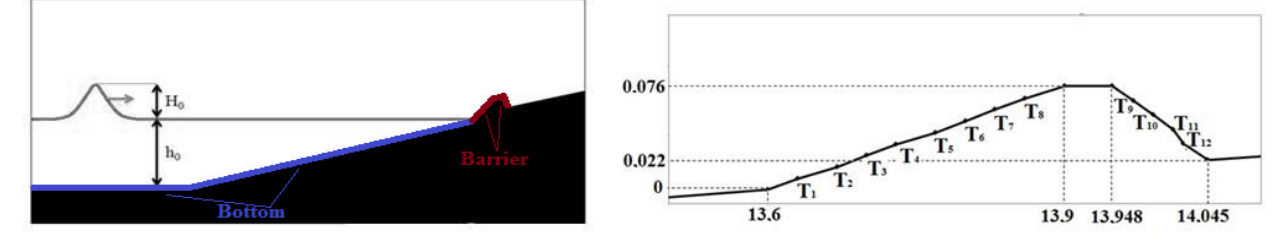
Figure 1. Schematic representation of the problem. Elevation coordinates of the barrier are given in Table 1. Table 1. Elevation coordinates of the barrier.